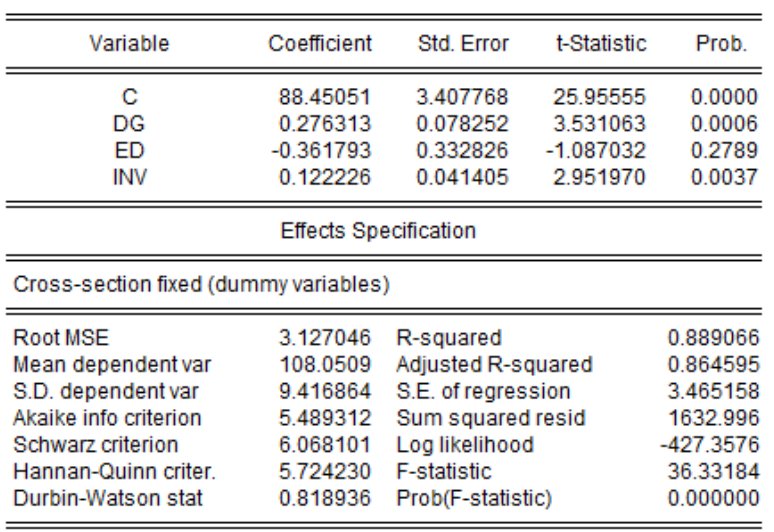
Figure 16. Least squares method—the effect of digitalization, education, and investment on labor productivity (EViews).